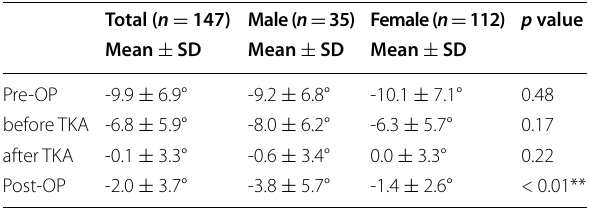
Table 3 Mean value of the knee extension angles at each time